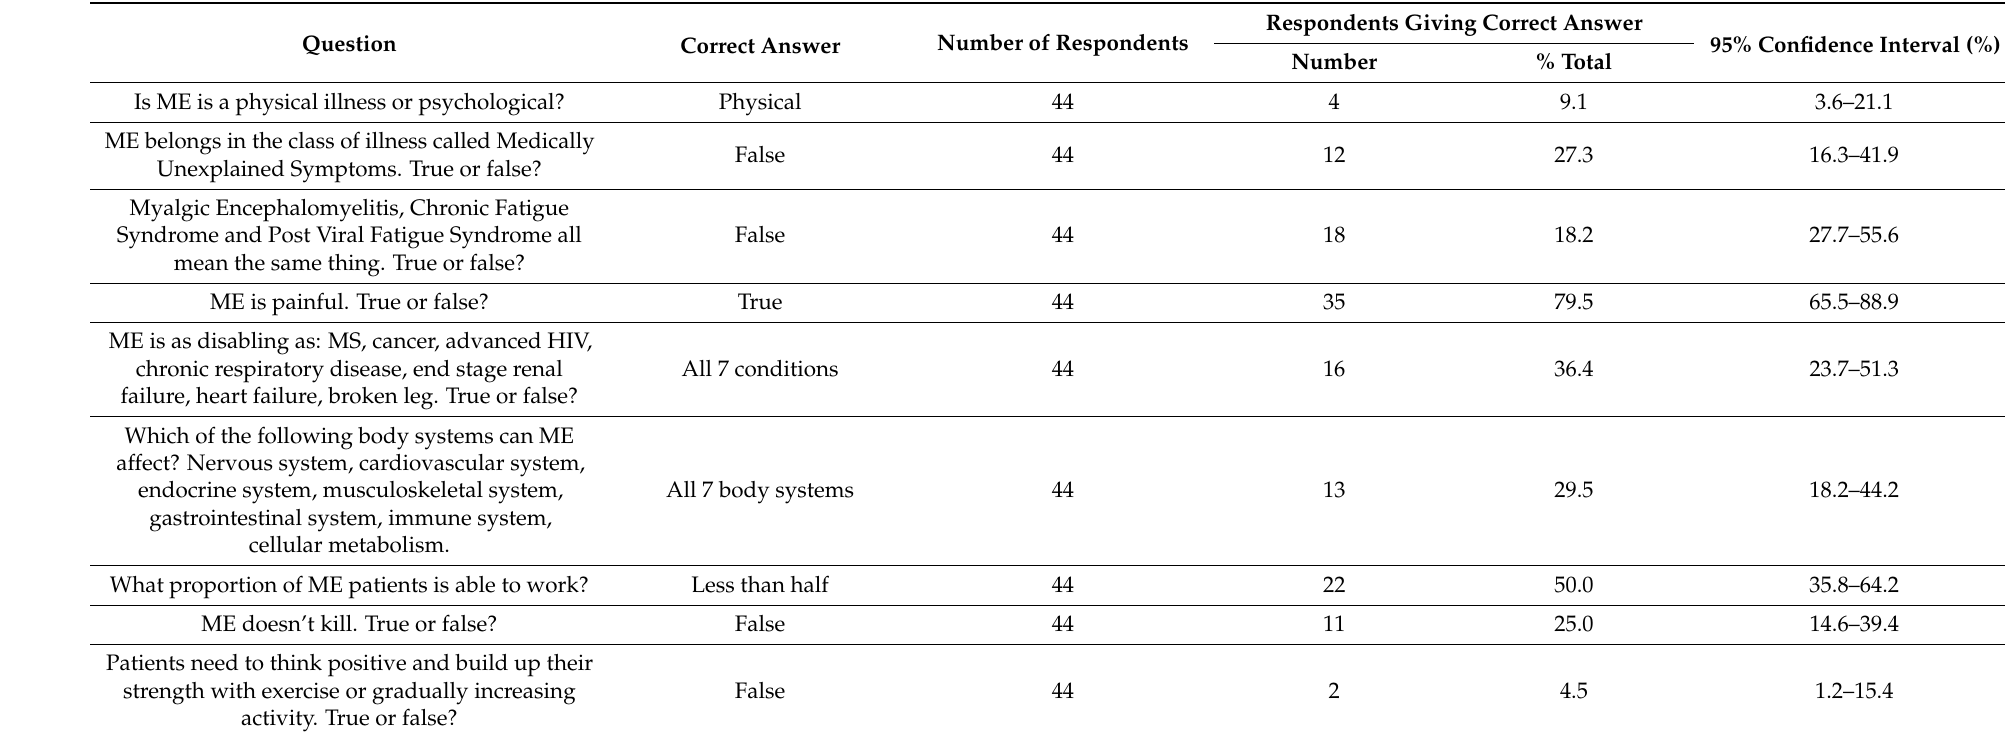
Table 5. Respondents’ knowledge of definitions and clinical